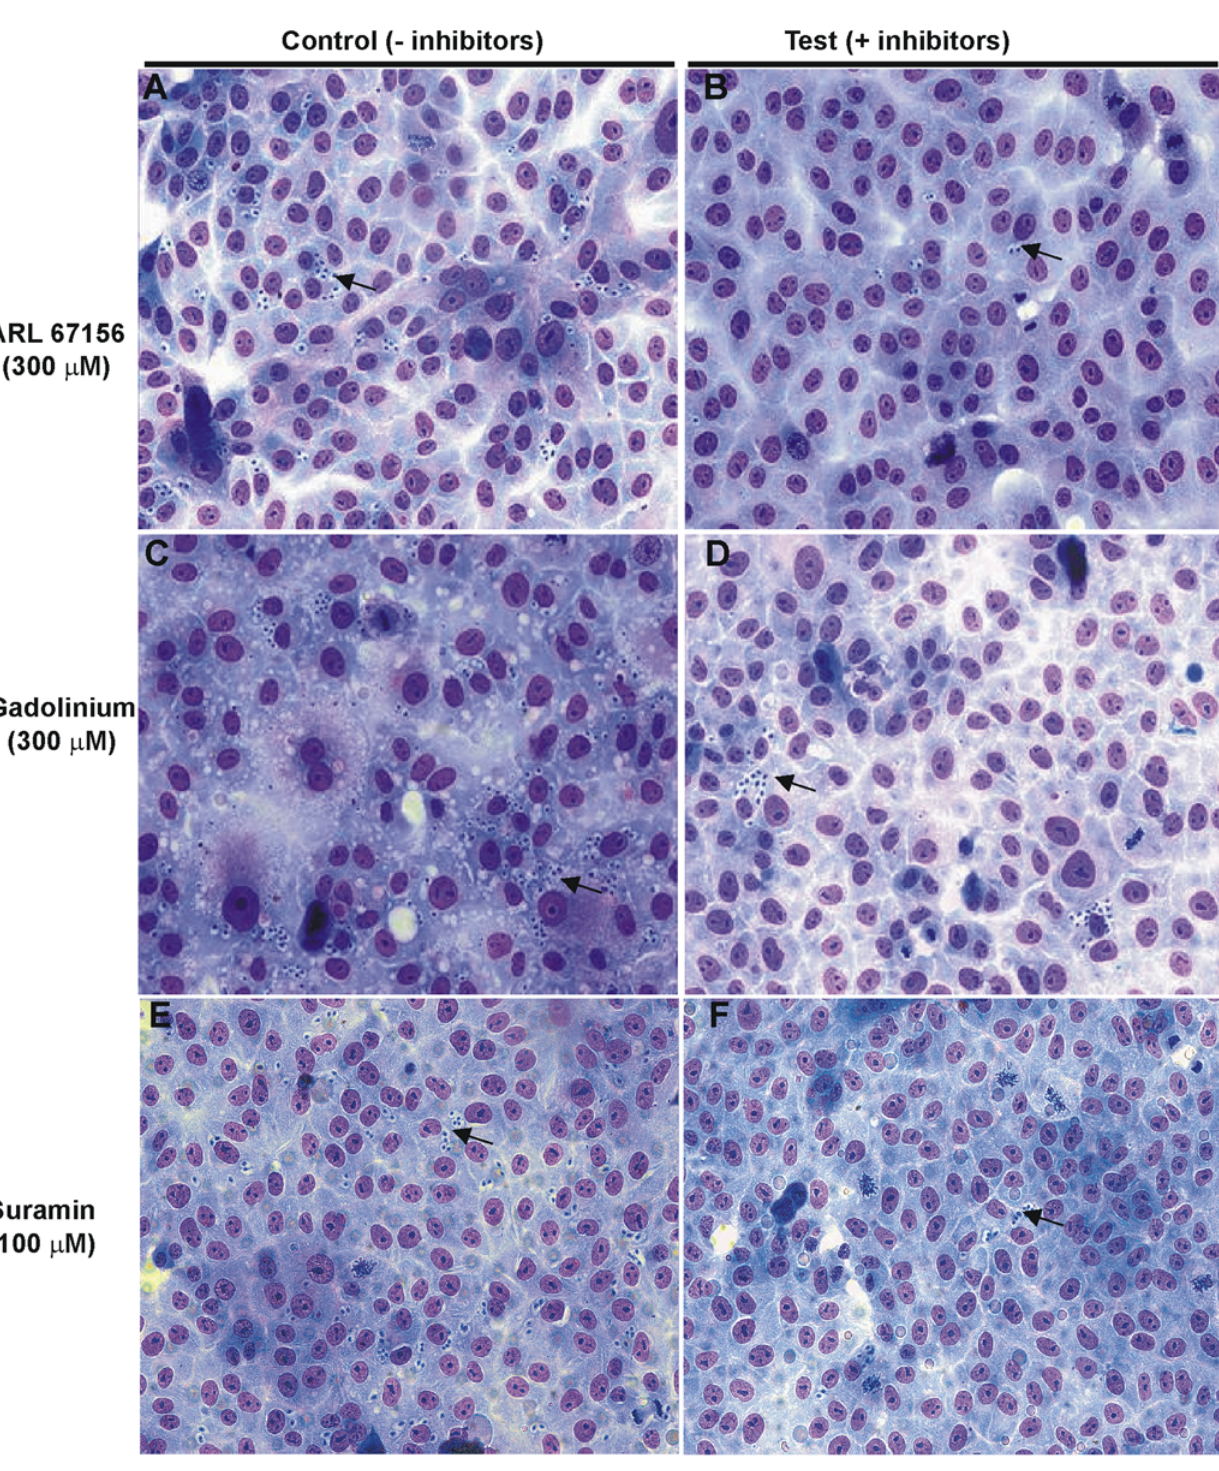
Figure 4. Effects of ecto-ATPDase inhibitors on invitroT.cruzi infectivity. Microphotographs of VERO cell monolayers infected with trypomastigotes not treated (panels A,C,E) or treated with Ecto-ATPDase inhibitors (panels B,D,F). P1 trypomastigotes (Y strain) were pre-treated with ARL 67156, Gadolinium or Suramin at the indicated concentrations, resuspended in medium without inhibitor and used in VERO cells invasion assays. After 24 hours post infection each assay slide was washed and stained with Giemsa. The arrows indicate many internalized amastigotes.